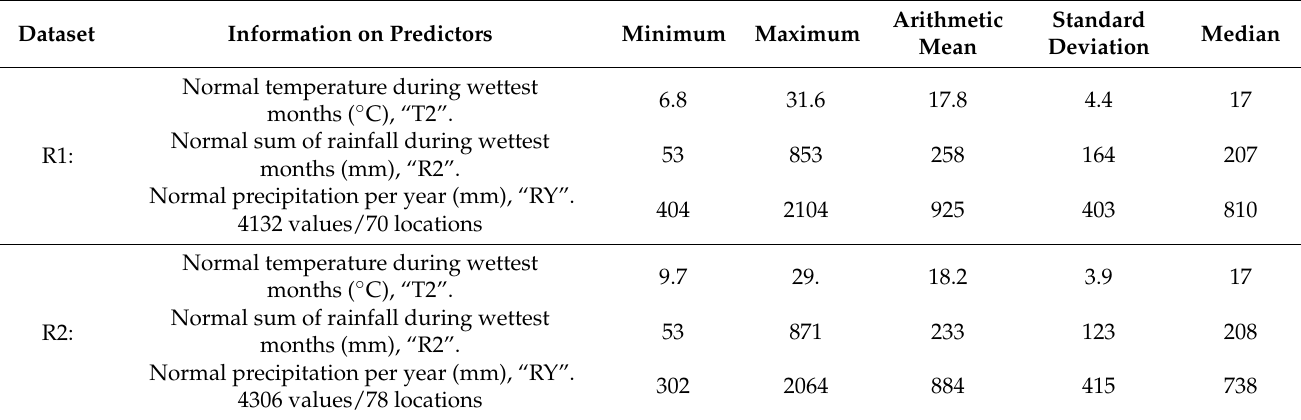
Table 3. Information on the datasets R1 and